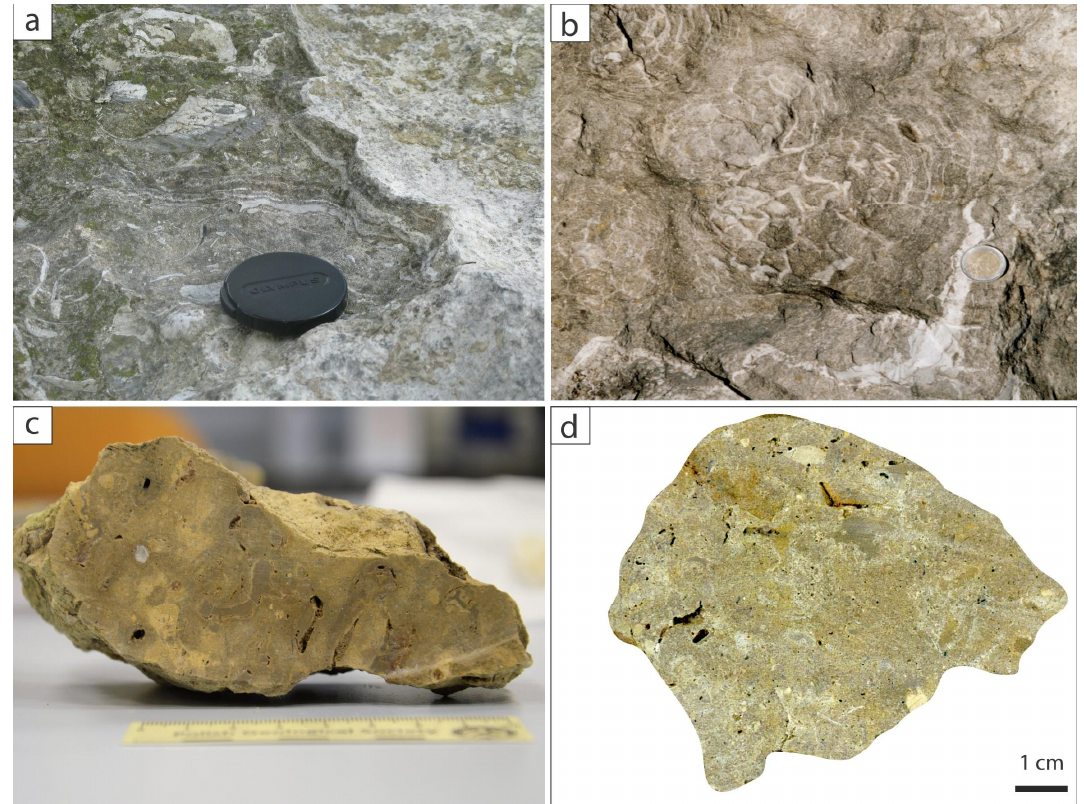
Figure 3. Examples of various clathrite‐like structures. ( a ) Thin layered structures surrounding a carbonate breccia with shell fragments (MP outcrop in Figure 1). ( b ) Irregular network (mainly radial to concentric) of carbonate‐filled veins (DE outcrop in Figure 1). ( c , d ) Vacuolar, spongy and vuggy‐like fabrics: cavities have various shape, empty or filled with carbonate cements and/or coarser sediments and coquina debris. PC outcrop ( c ) and SS outcrop ( d ) of Figure 1.